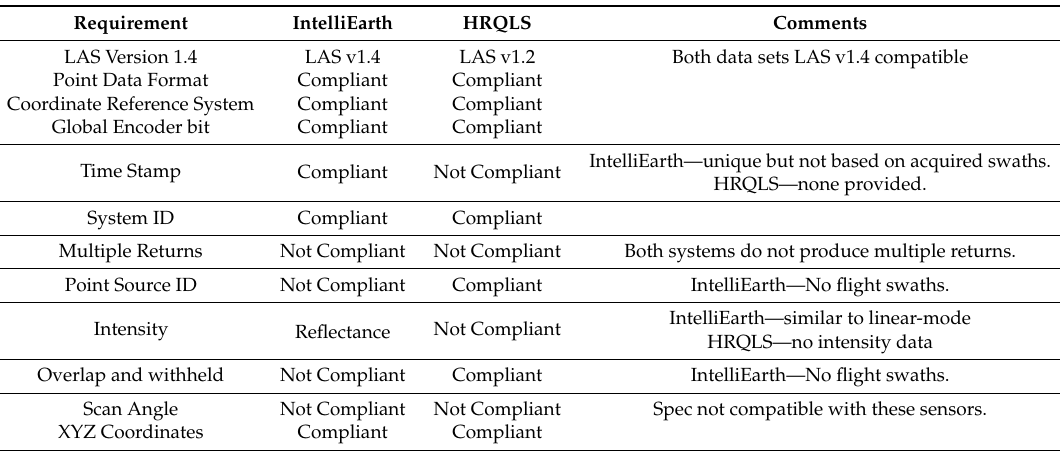
Table 3. Compliance to USGS Lidar Base Spec